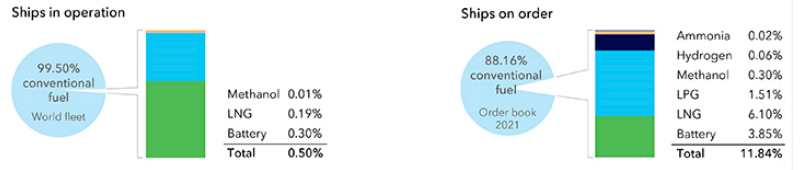
Figure 1. Alternative fuels uptake in 2021 (reproduced from [34] with permission of DNV,